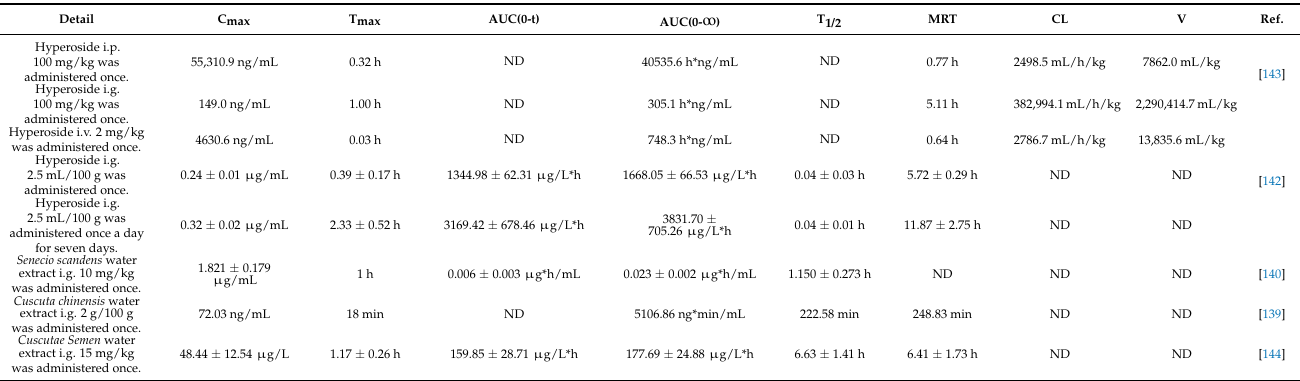
Table 12. Pharmacokinetic Parameters of Hyperoside and Traditional Chinese Medicine Containing Hyperoside.